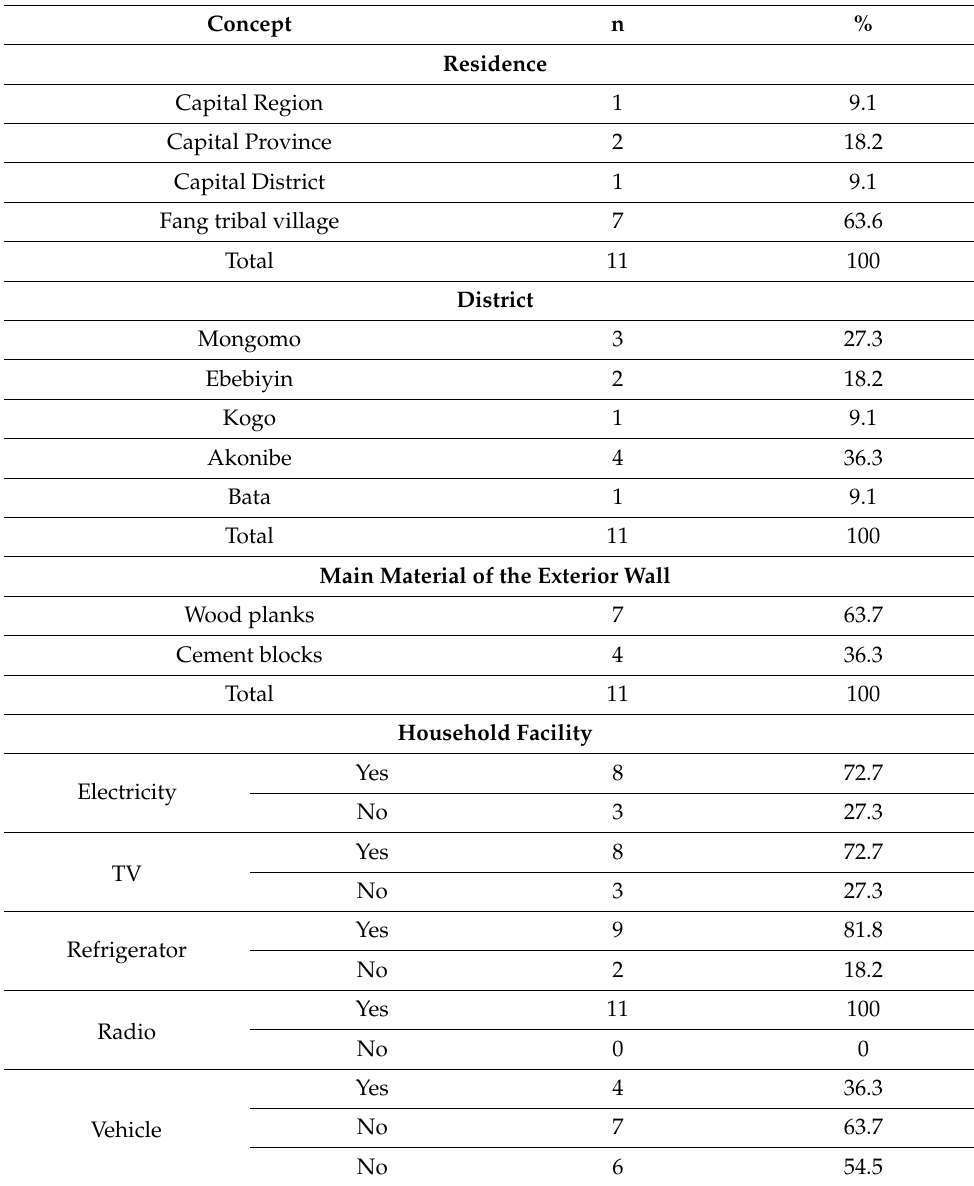
Table 4. Cont. 3.1. Household data of traditional healers (n =